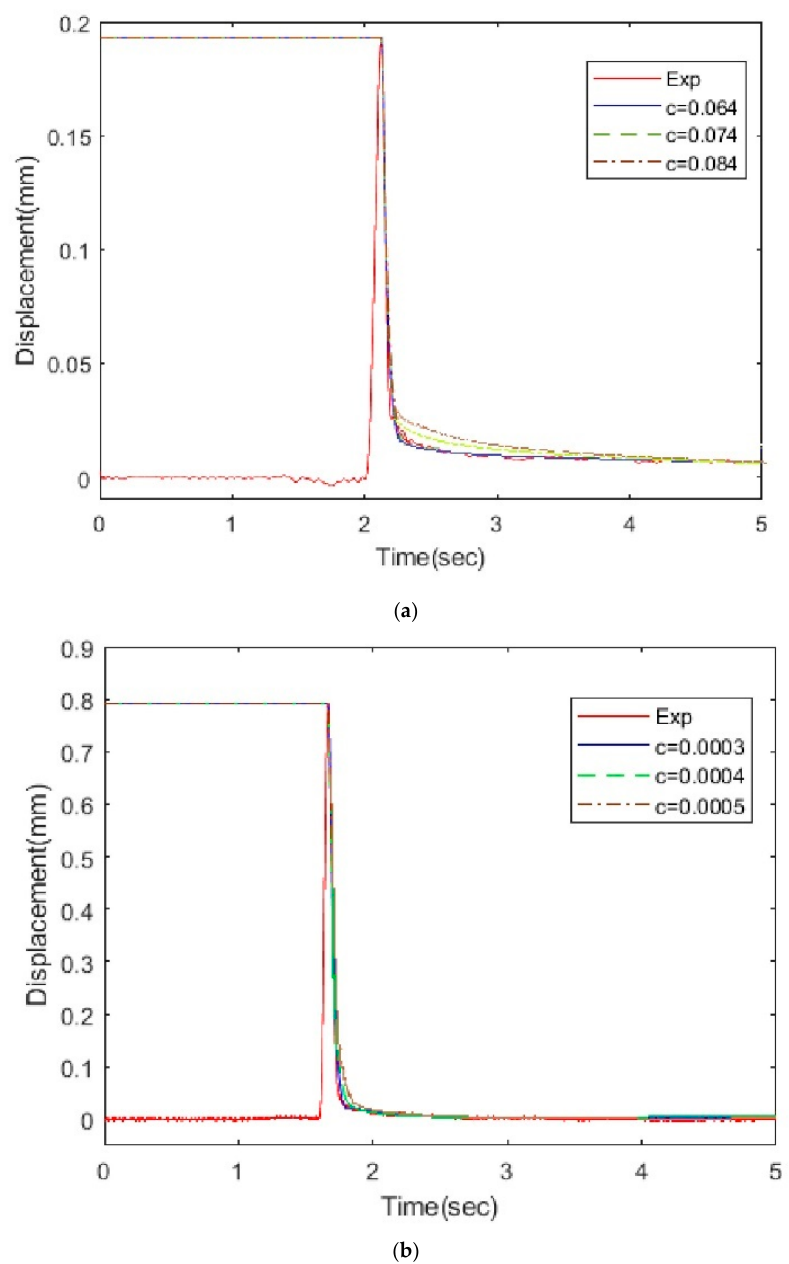
Figure 21. ( a ) Damping coefficient identification without VCA (conductive). ( b ) Damping coefficient identification without VCA (non-conductive).